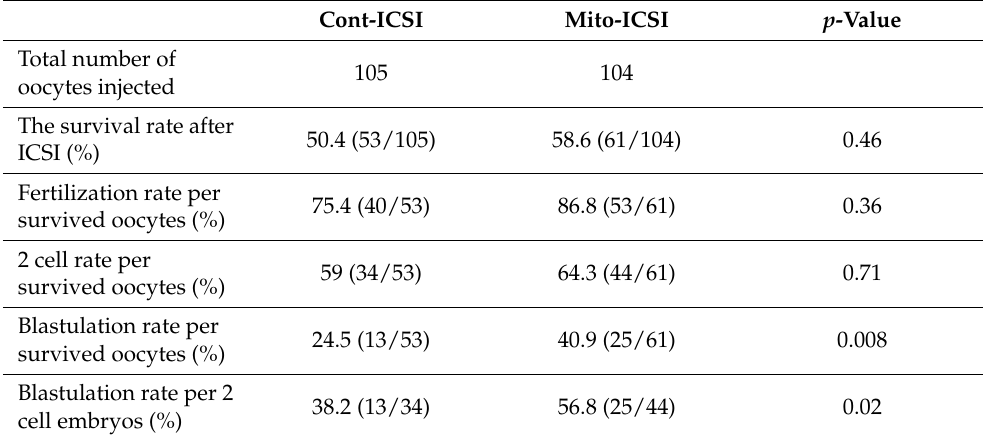
Table 1. Adipose stem cell mitochondria injection improves the blastulation rate of cryopre- served oocytes. Cont-ICSI Mito-ICSI p -Value